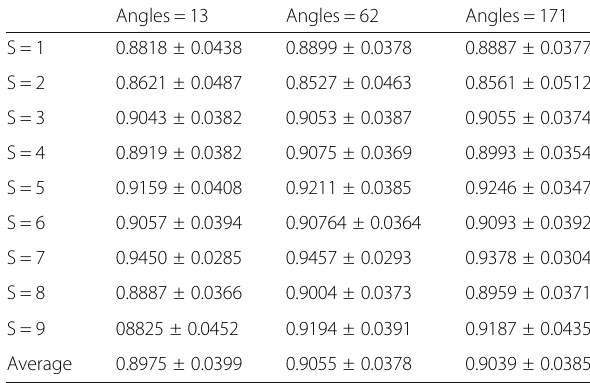
Table 6 AUC scores of LMA with duplicates angles over 100 training and testing groups